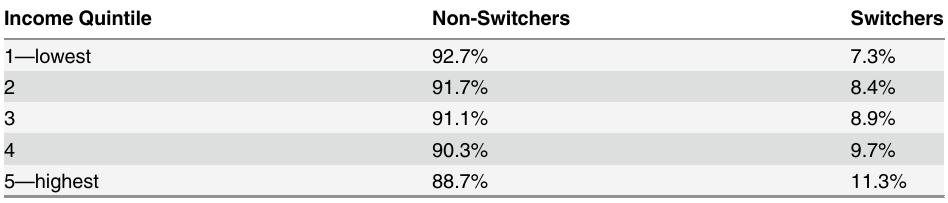
Table 4. Assessment for Trend of Switchers across Income Quintiles Prior to ODBP listing of